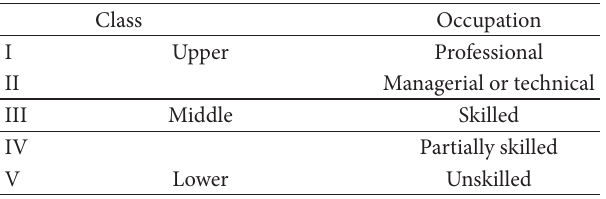
Table 1: Oyedeji socioeconomic classification